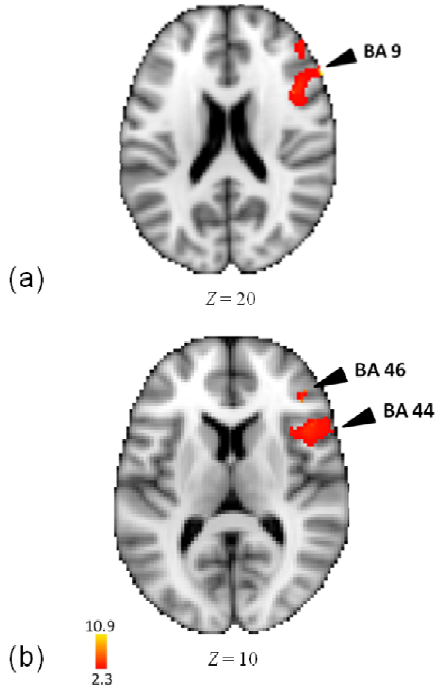
Figure 4. ( a ) Activations in middle and inferior frontal gyri in the analysis of meter task